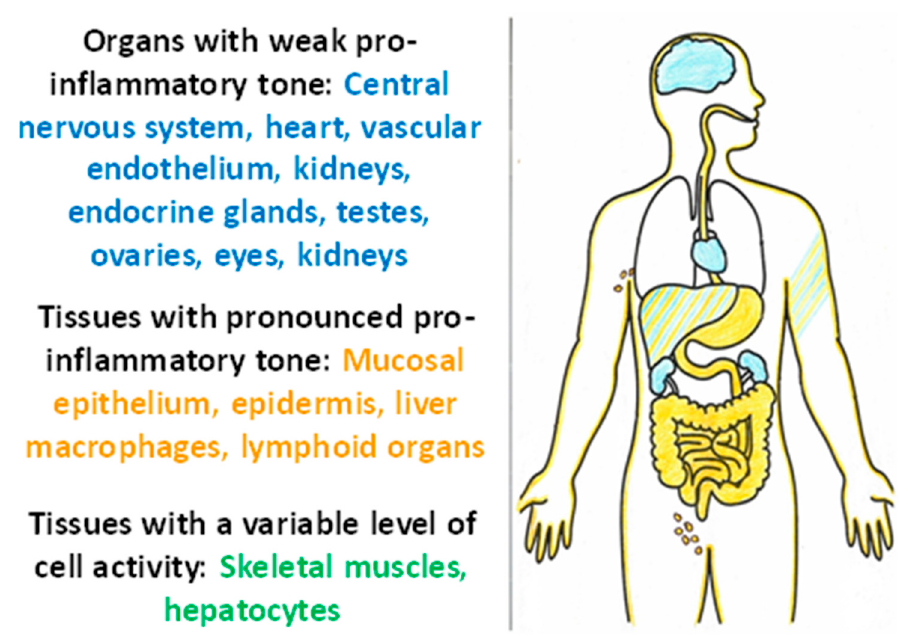
Figure 5. Organs with varying degrees of tissue stress under physiological conditions.